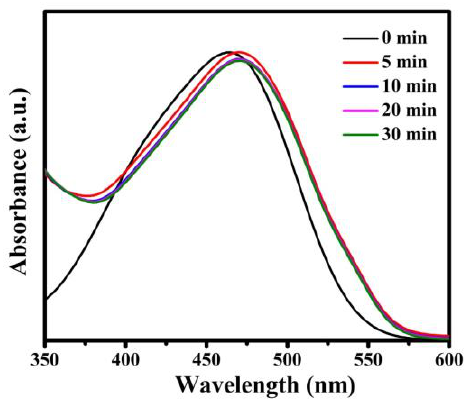
Figure 12. Adsorption spectra of the MO solution under the dark in presence of Fe 3 O 4 @1 .